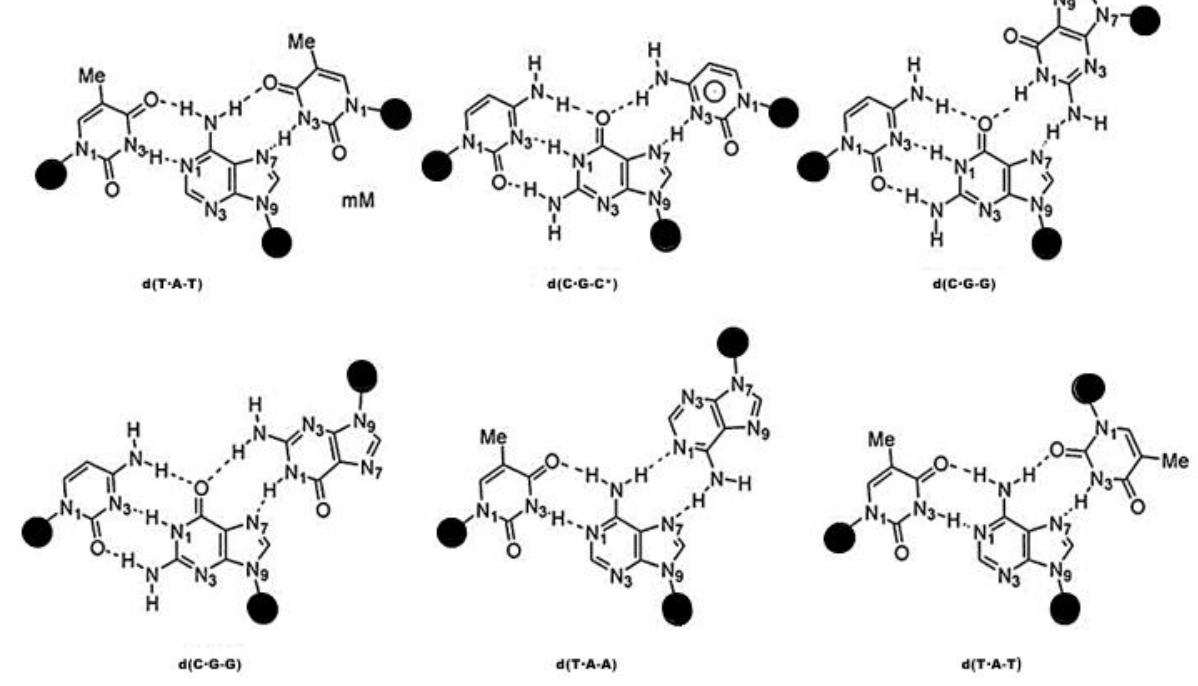
Figure 1. Hoogsteen-based triads are shown schematically in parallel and anti-parallel triplexes, as well as in triads based on the reverse Hoogsteen algorithm.